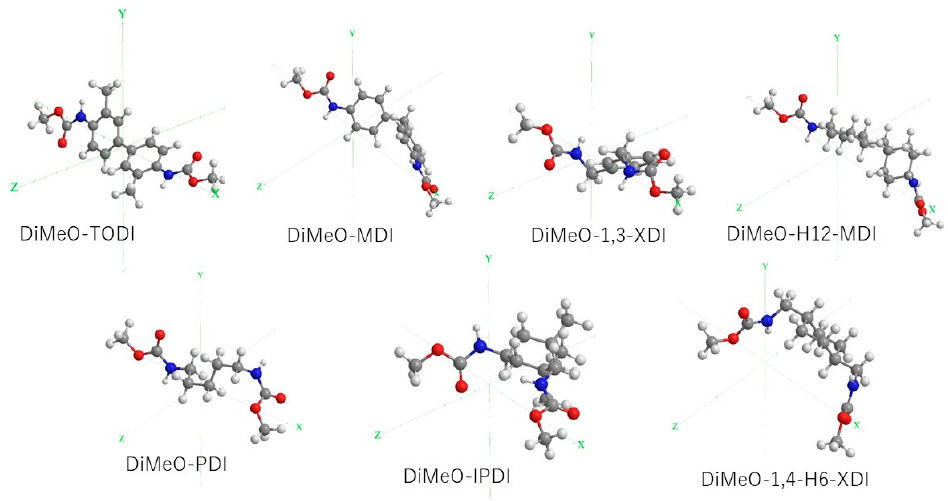
Scheme 5. Stable structures of the molecules used to calculate the